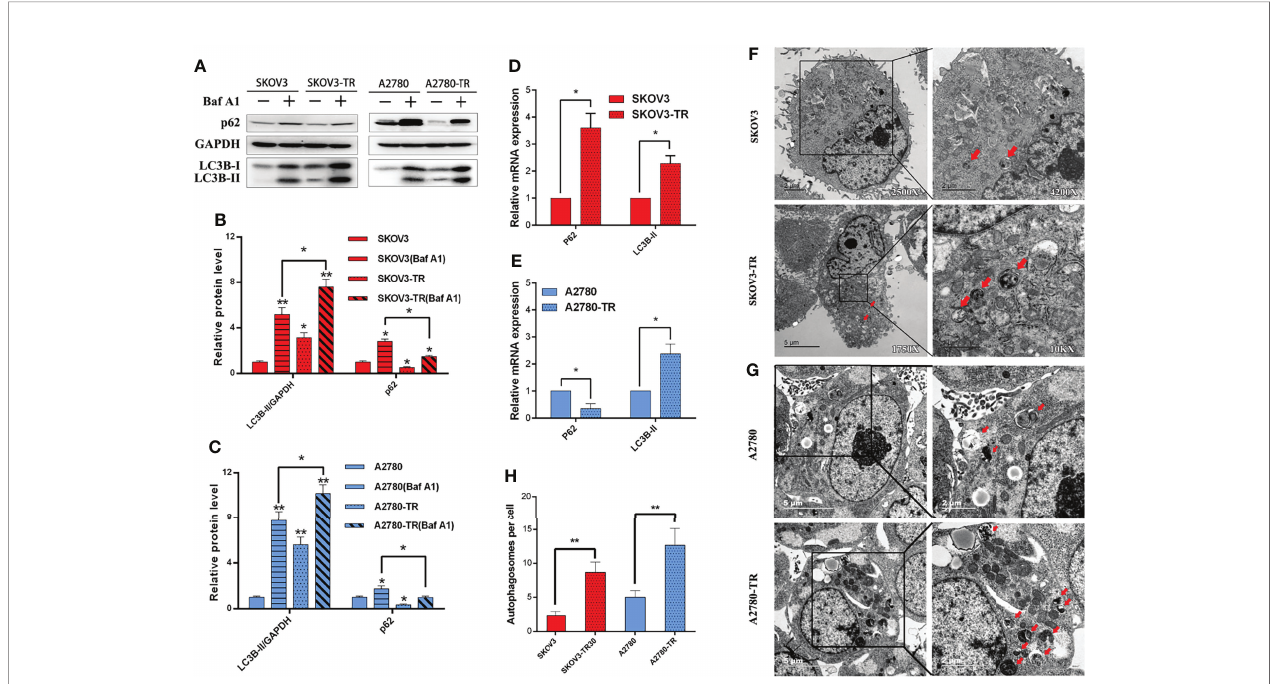
FIGURE 5 | Autophagy detection in SKOV3, A2780, SKOV3-TR, and A2780-TR cells. (A – C) Western blot showed p62(SQSTM1) and LC3B levels in SKOV3, A2780, SKOV3-TR, and A2780-TR cells. The densitometric evaluations are calculated by ImageJ. (D, E) The expression of autophagy was determined by real-time PCR. (F – H) The autophagic vacuoles (autophagosomes) were detected in SKOV3, SKOV3-TR, A2780, and A2780-TR by transmission electron microscopy (TEM). The representative TEM images are shown and the typical autophagosomes are marked with red arrows. The number of autophagosomes per cell was calculated by counting the number of double-membrane organelles in 10 cells. (*p < 0.05, **p < 0.01, n = 3, student t-test, means ± 95%